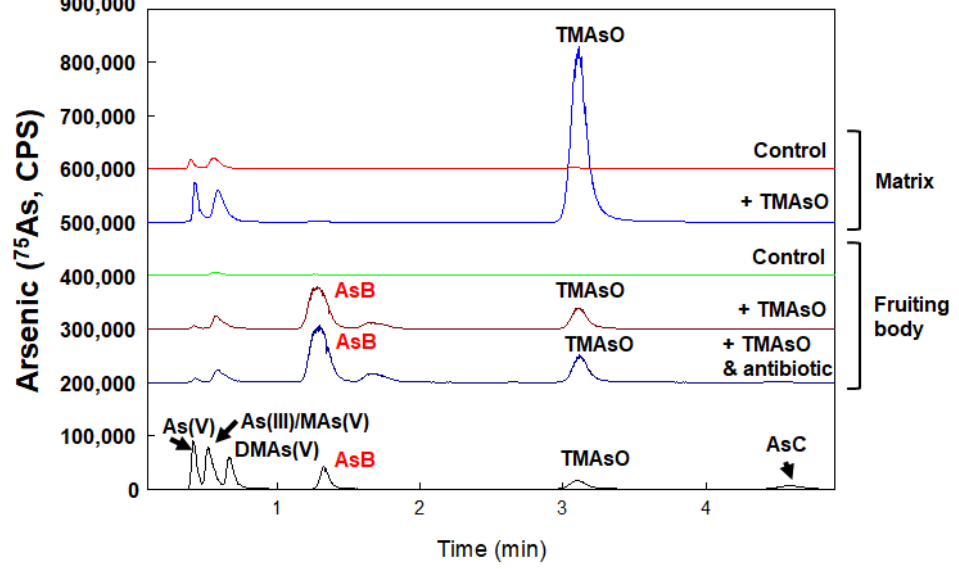
Figure 4. AsB is synthesized in the reproductive but not vegetative stage and antibiotic treatment does not affect AsB synthesis. Arsenic species in mycelium (culture matrix) and fruiting body were determined by HPLC-ICP-MS and compared in controlled culture and TMAsO treated culture. Results suggested that AsB is only synthesized in the fruiting body but not in mycelium in the culture compost when treated with TMAsO. Arsenic speciation in the fruiting body treated with TMAsO were also compared with the chloramphenicol treated culture (at final concentration of 50 mg/Kg in compost). Results showed that AsB was detected in both conditions with comparable levels. One representative data out of the three replicates is shown.